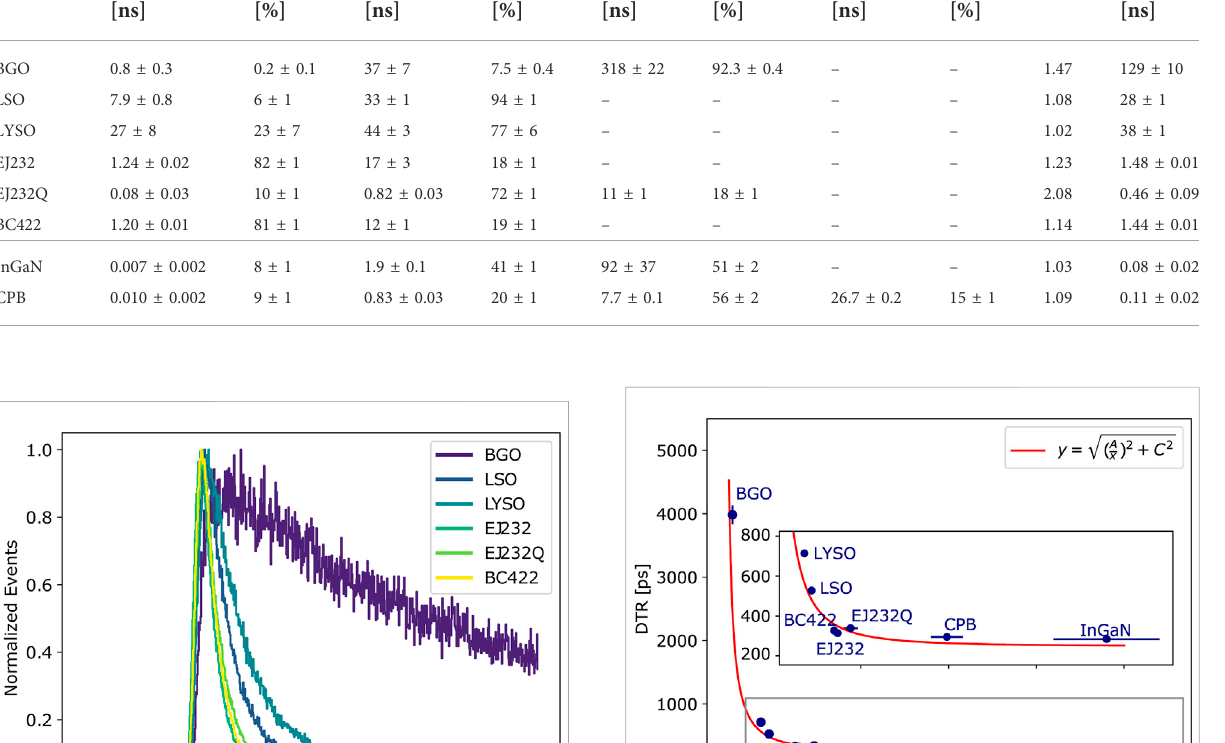
TABLE 2 Summary table with decay time components resulting from the bi-exponential fi t of scintillation pulses of all measured samples. Sample